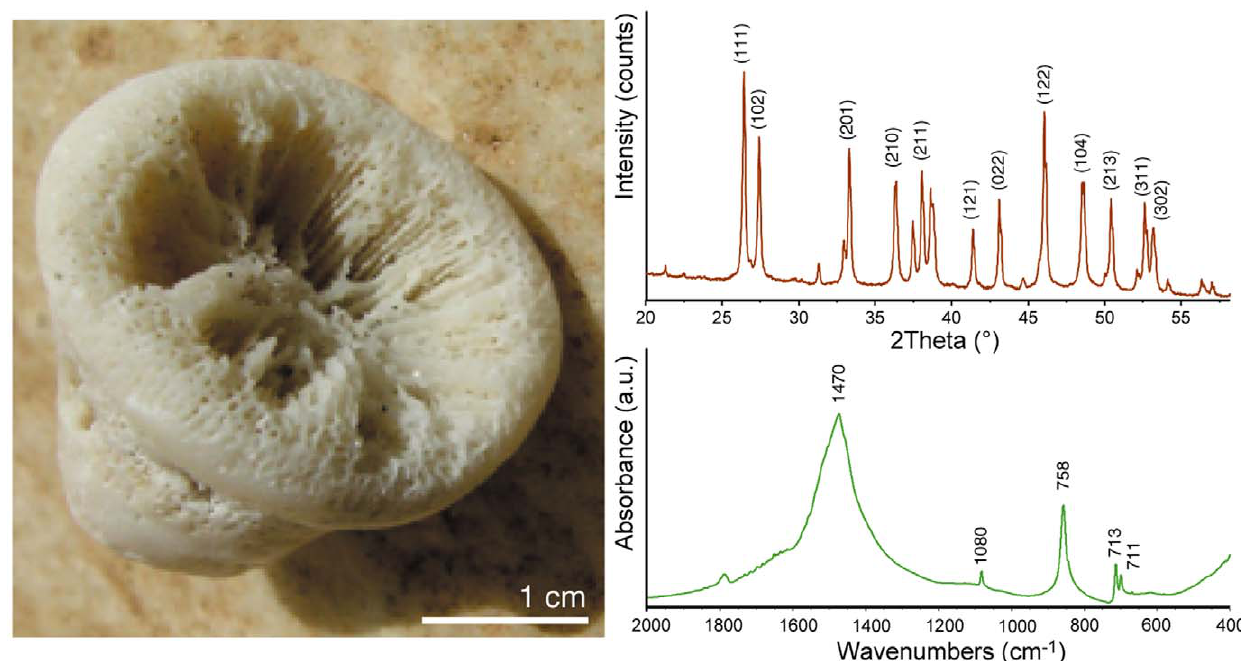
Figure 1. Skeleton of the coral Balanophylliaeuropaea . (A) Digital camera picture of the skeleton of the coral Balanophyllia europaea after digestion in a sodium hypochlorite solution to remove the soft organic tissues. (B) X-ray powder diffraction pattern from a powdered coral skeleton sample. Only the characteristic diffraction peaks from aragonite are observable. The main diffraction peaks of the Miller index are indicated according to the reference pattern PDF 98-006-0908 [60]. (C) FTIR spectrum from a powdered coral skeleton sample. Only the typical absorption bands from aragonite were detected. They were assigned as n 2 =858 cm 2 1 ; n 3 =1470 cm 2 1 ; n 4 =713 cm 2 1 [42].